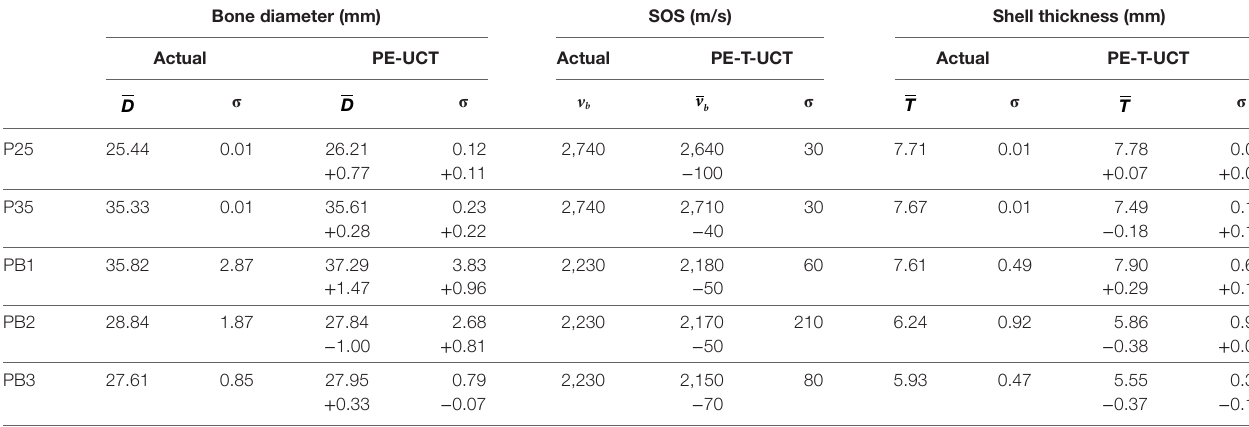
TaBle 1 | Tabulated results of the PE-UCT measured mean bone diameter and PE-T-UCT measured mean SOS and mean shell thickness. Bone diameter